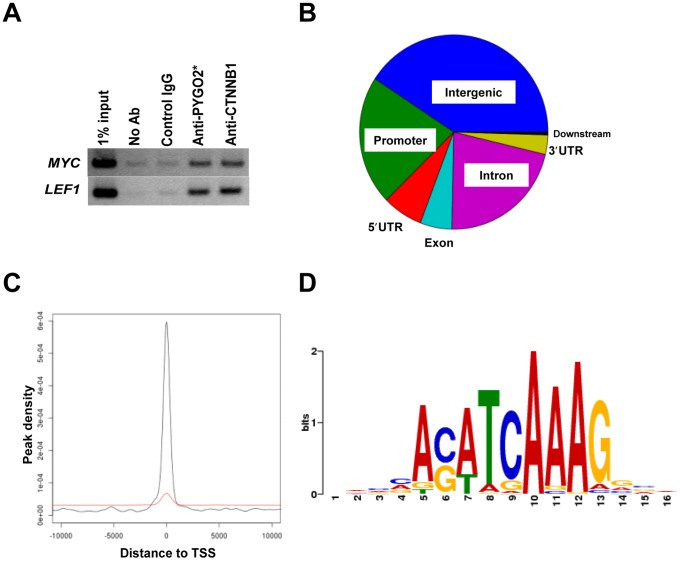
Peak distribution and motif analysis of CTNNB1 ChIP-seq.
A. ChIP optimization. ChIP-PCR was performed for known CTNNB1-binding elements in MYC and LEF1 gene regulatory regions. *anti-PYGO2 antibody was used as a positive control, as PYGO2 protein associates with the CTNNB1-TCF/LEF protein complex [51]. B. Distribution of CTNNB1-binding regions on the genome relative to RefSeq human genes. A ‘promoter’ is defined as the 2-kb region upstream of the TSS, whereas a ‘downstream’ region is defined as the 2-kb region downstream of the transcription termination site. Intergenic region refers to all locations other than ‘promoter’, 5′-UTR, ‘exon’, ‘intron’, ‘3′-UTR’, or ‘downstream’. C. Distance from the center of each CTNNB1 binding peak to the TSS of the nearest gene. The red line represents a randomly distributed pattern generated by taking 1000 random permutations of the peaks. D. MEME program identifies a consensus TCF/LEF-binding motif within the ChIP-seq peaks.